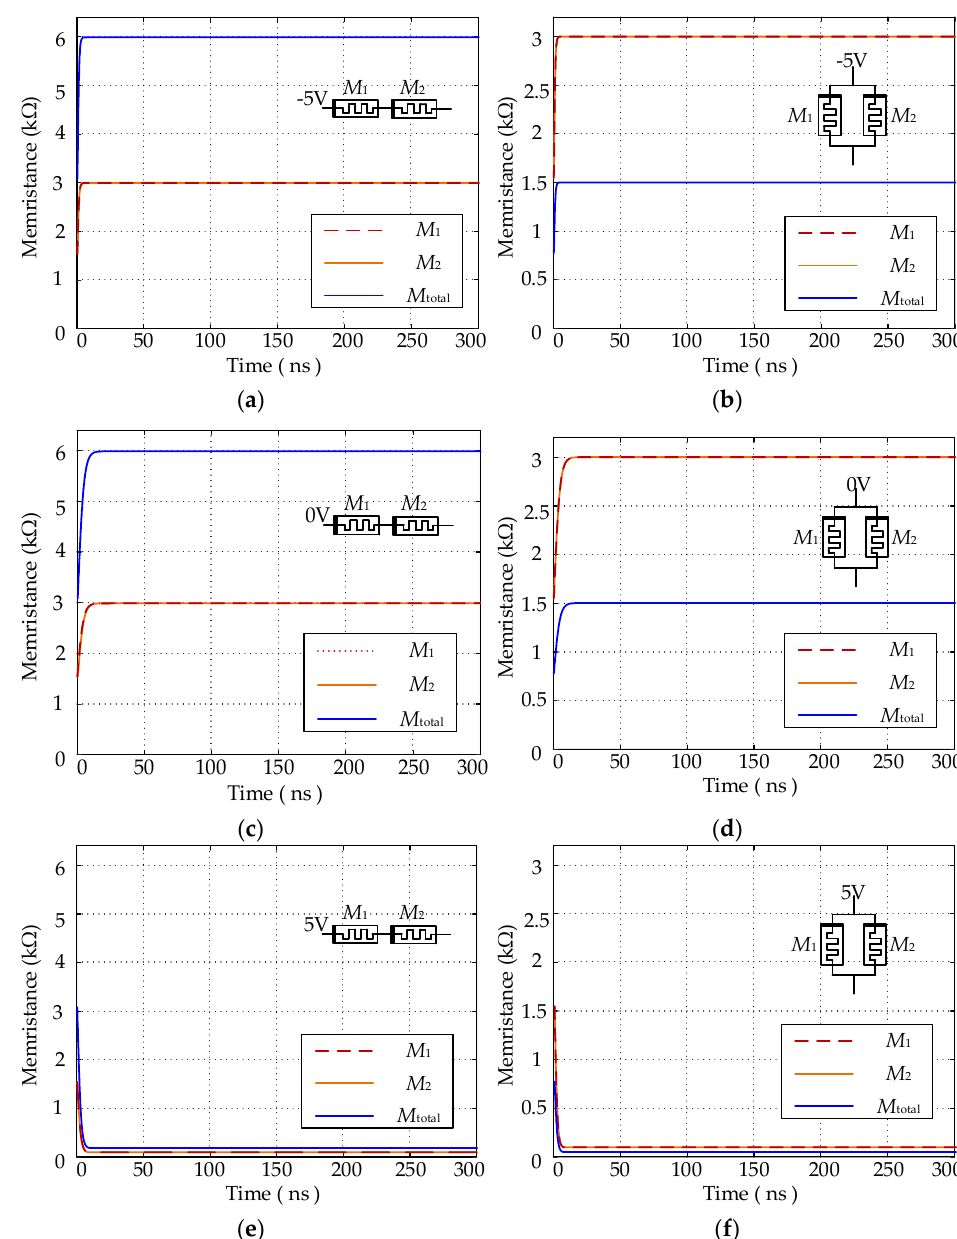
Figure 5. Electrical characteristic curves of the memristor composite circuit at the optical power density of 100 W/m 2 showing ( a , c , e ) M − t curves of the series circuit at − 5 V, 0 V, 5 V; and ( b , d,f ) M − t curves of the parallel circuit at − 5 V, 0 V, 5 V.